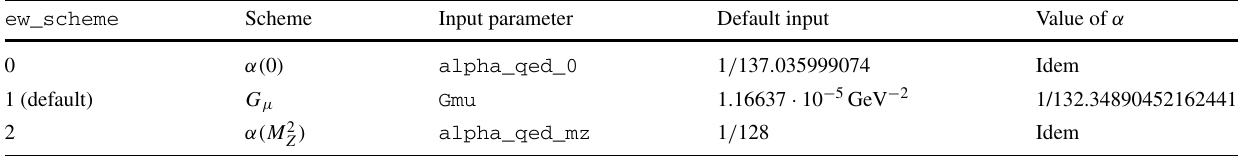
Table 1 Available EW input schemes and corresponding values of the ew_scheme selector. For each scheme the default values of the corre- sponding input parameter is indicated. Note that instead of α( M 2 1 / 127 . 94 [69] we use 1 / 128. Assuming the default weak-boson mass